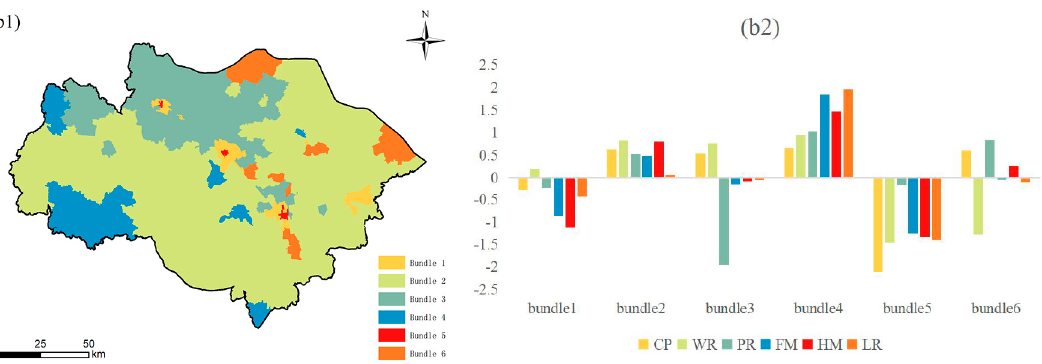
Figure 8. ( a1 ) Spatial distribution of ES budget bundles at the county scale; ( a2 ) ESDR of ES budget bundles at the county scale. Note: The histogram is obtained by the Z-score normalization method. The abscissa represents the six ES budget bundles on the county scale.; the vertical axis is the Z-score. When the Z-score = 0, it represents the average value of ESDR. A Z-score > 0 indicates above-average values, and a Z-score < 0 indicates below-average values.